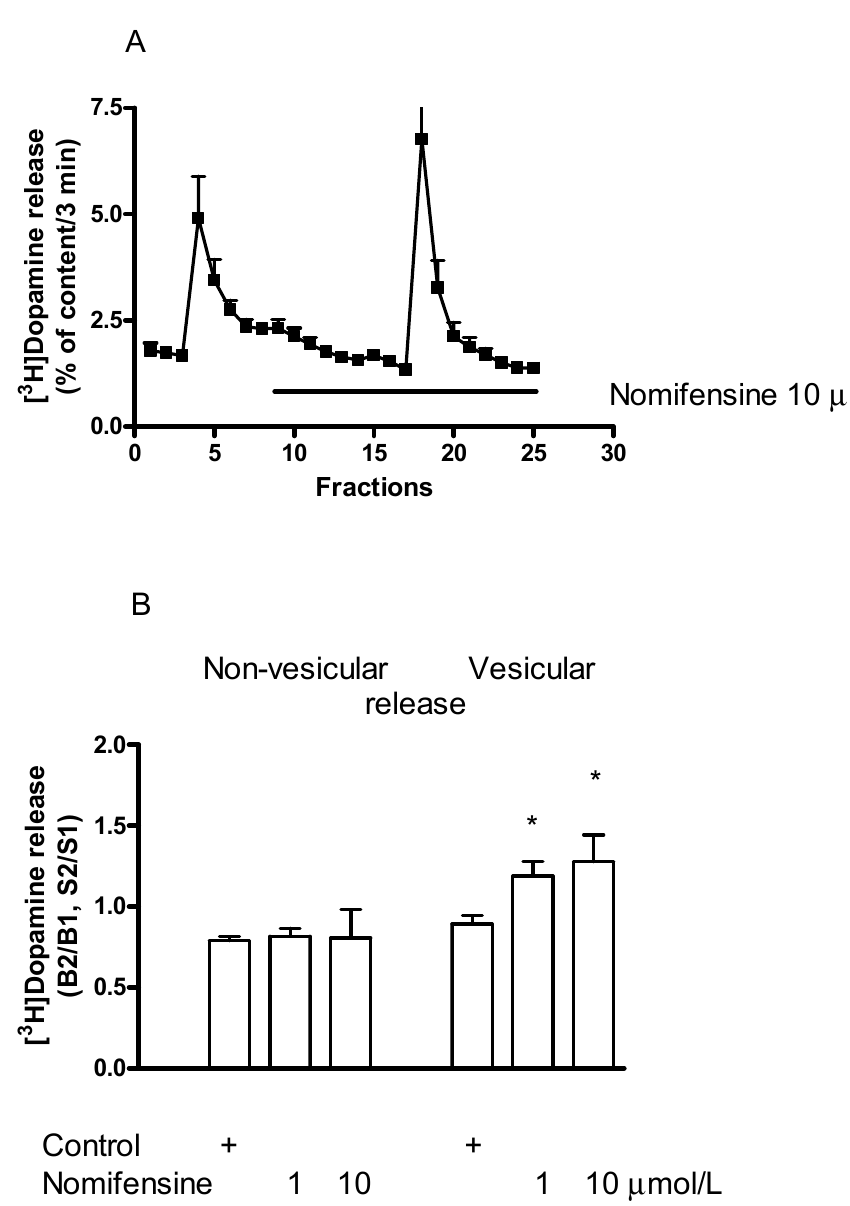
Figure 7. Effect of nomifensine on [ 3 H]dopamine release from rat striatum. For the